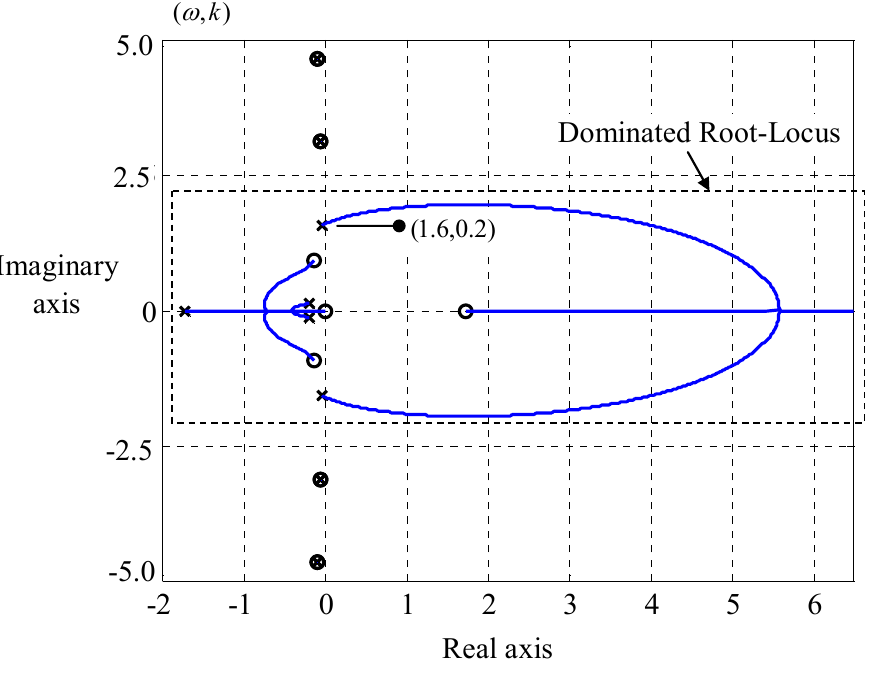
Figure 9. The Root locus of generalized plant M ,